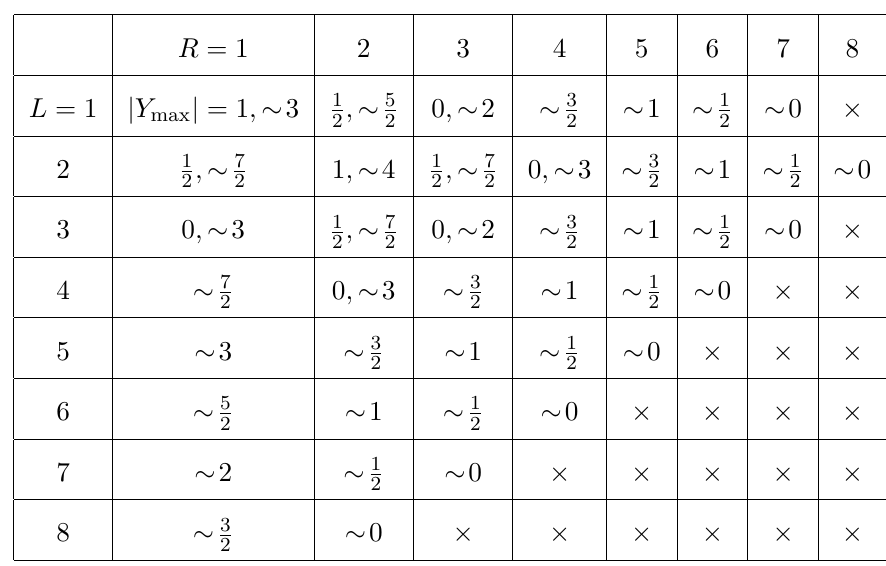
Table 9 . The representations of scalar BSM Loryons still viable after considering constraints on S . A ∼ means the representation is not viable on its own but can be added together with other BSM representations to flip the sign of κ . γ